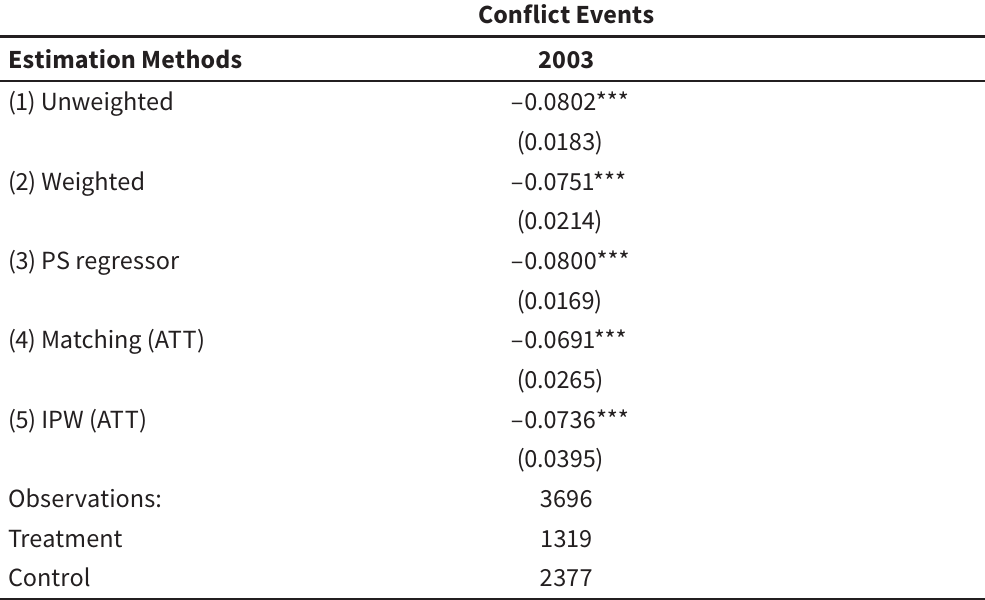
Conflict Events